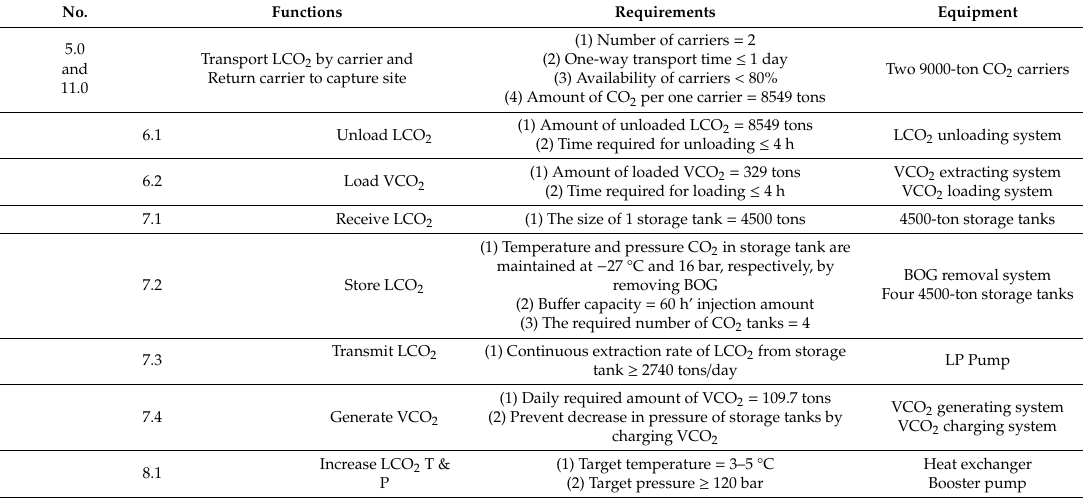
Table 1. The derived requirements and equipment corresponding to functions of the CO 2